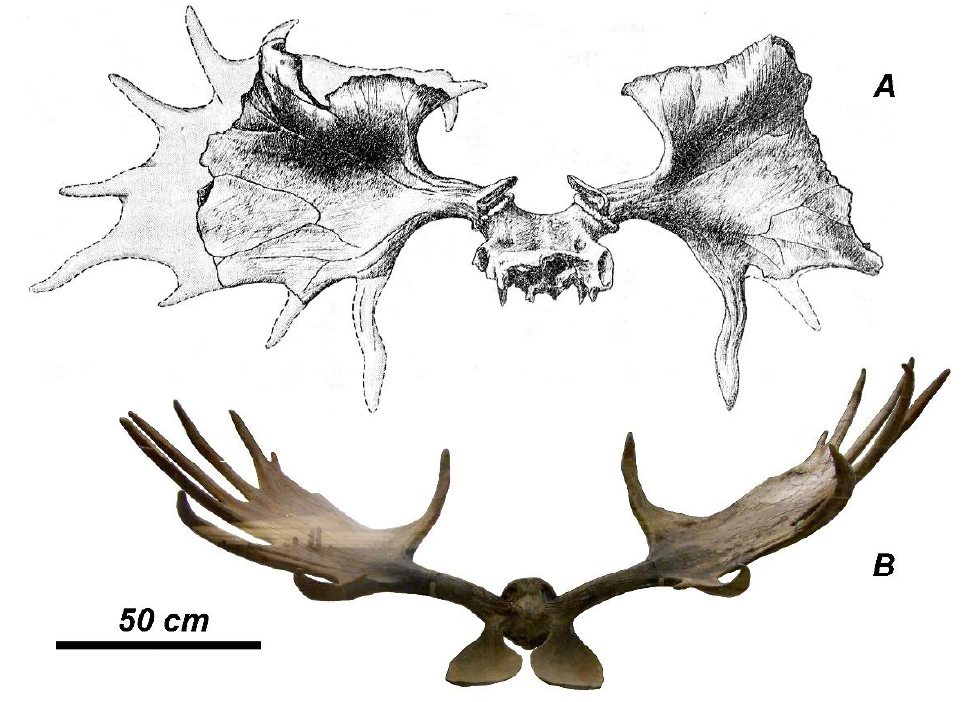
Figure 8. ( A ), the type specimen of Megaloceros giganteus padanus (Vialli, 1939) discovered near Polesine Parmense, Italy (adapted from Vialli [33]); ( B ), the antlered frontlet of Megaloceros gigan- teus antecedens (Berckhemer, 1941) from Steinheim, Germany (Nr. 16 280,